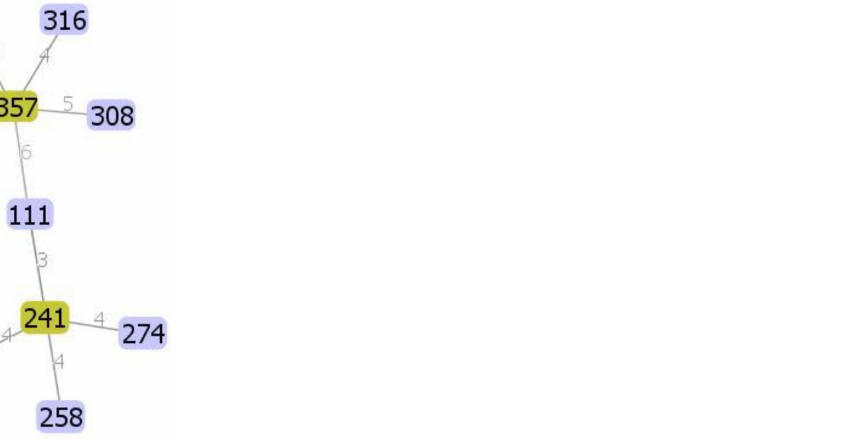
Figure 2. The goeBURST distance for the 10 sequence types obtained from the P. aeruginosa isolates ( n =